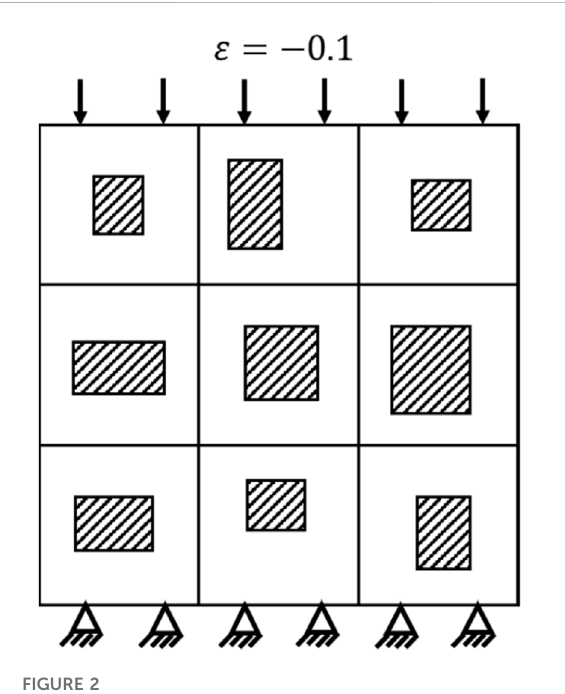
FIGURE 2 Loading and constraint de fi ned in the fi nite element analysis ( “ ε ” refers to the